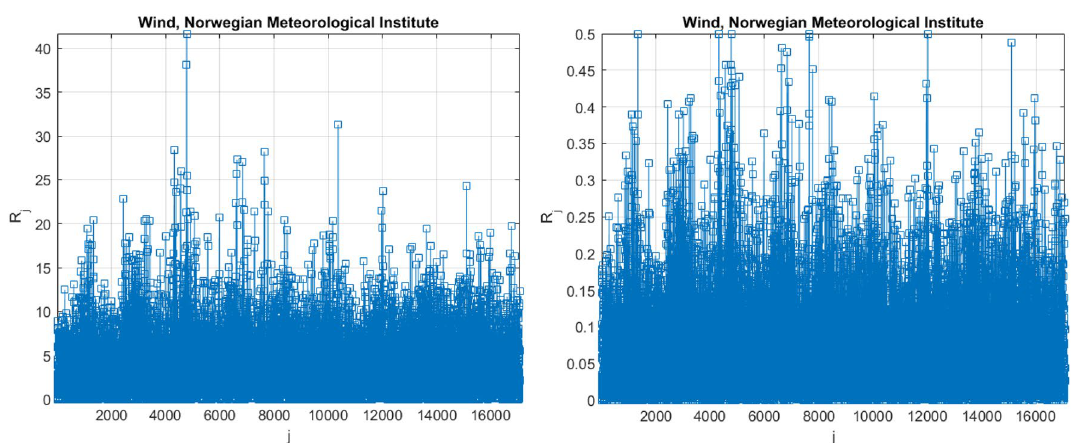
Figure 5. Left: unscaled raw daily largest highest daily wind cast speed data [m/sec], Right: scaled non- dimensional assembled 5D vector −→ R